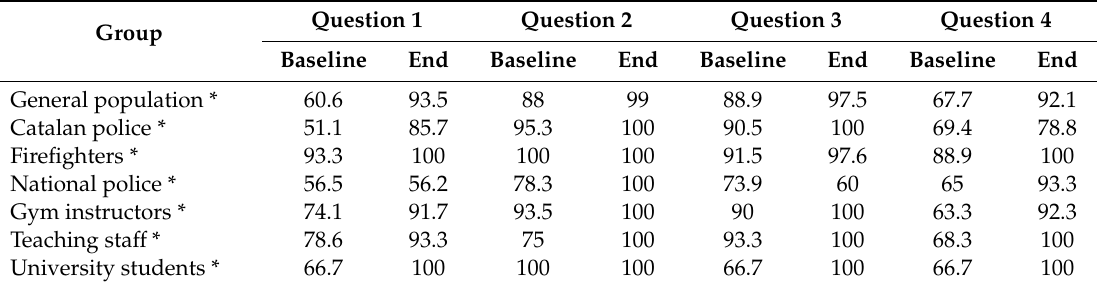
Figure 3. Percentages of participants who responded correctly to the evaluation questionnaire at baseline and at the end of the training. Values expressed in percentage. All questions: p < 0.05 between different time-points (baseline and at the end of the training courses). Table 2. Percentage of participants who responded correctly to the evaluation questionnaire at baseline and at the end of the training courses by groups.